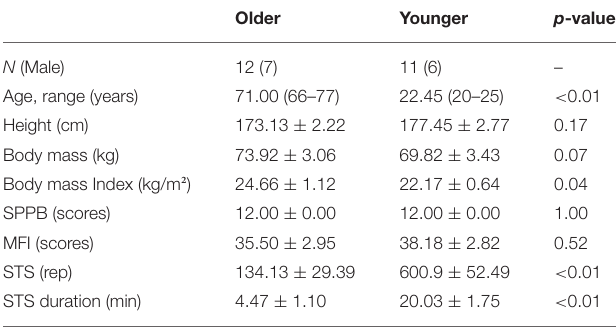
TABLE 2 | ANOVA main effects and interaction and partial eta-squared ( η 2 p ) for the outcomes.